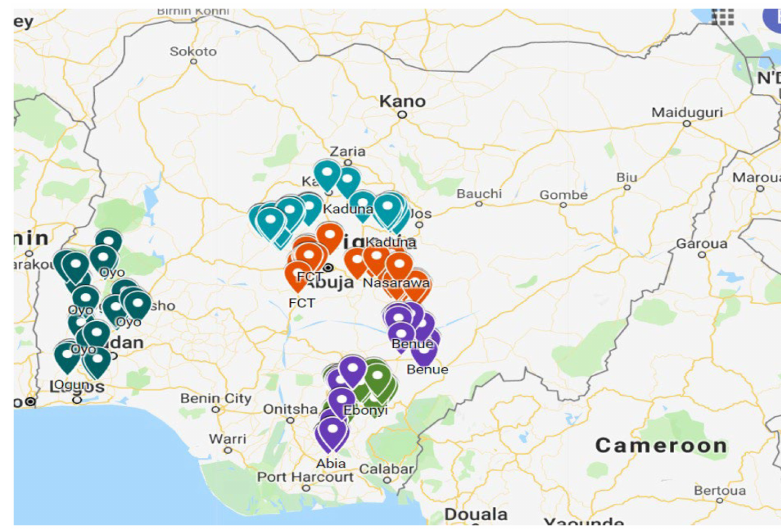
Figure 1. Study area depicting the locations of demonstration